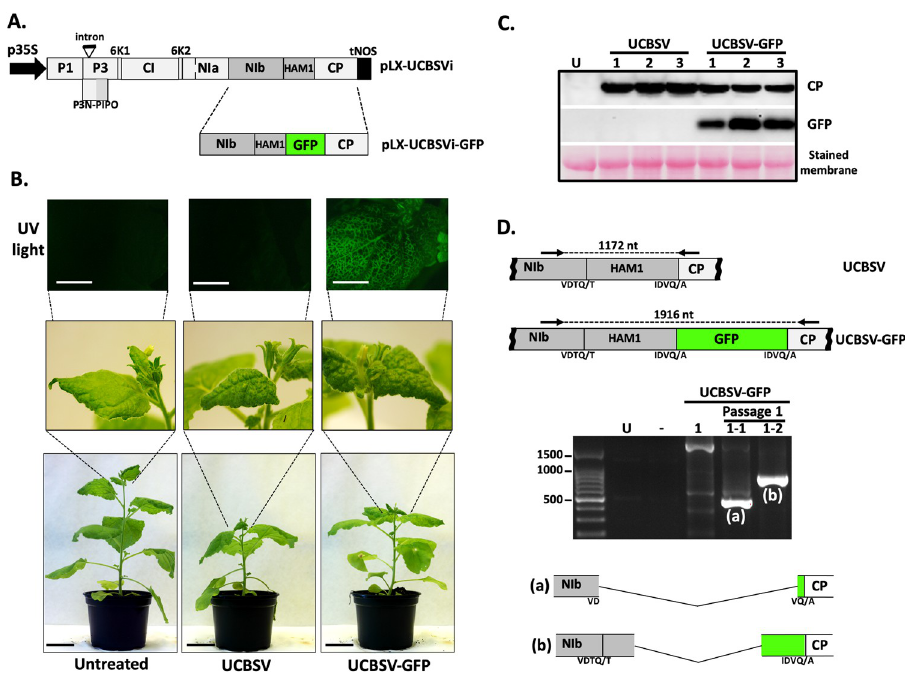
Fig 1. GFP-tagged UCBSV loses HAM1 and GFP coding sequences after one passage in N . benthamiana . (A) Schematic representation of viral constructs based on the pLX-UCBSV [25] used in this experiment. Boxes represent mature viral factors as they are encoded in the viral genome. The presence of an intron in the P3 coding sequence is also indicated. p35S: 35S promoter from cauliflower mosaic virus; tNOS: terminator from the NOS gene of Agrobacterium tumefaciens . (B) Representative pictures taken at 15 days post-inoculation of infected and non-treated N . benthamiana plants under UV radiation and visible light (white bar = 1 cm; black bar = 4 cm). (C) Detection of GFP and UCBSV CP by immunoblot analysis in protein samples from upper non-inoculated leaves of N . benthamiana plants infected with the indicated viruses. Blot stained with Ponceau red showing the large subunit of the ribulose- 1,5-bisphosphate carboxylase-oxygenase is included as a loading control (D) Agarose gel electrophoresis analysis of a viral genomic fragment amplified by RT-PCR from plants infected with UCBSV-GFP after one passage. The upper part shows a schematic representation of the amplified fragment. Black arrows represent primers used for amplification. Sizes of expected PCR products are indicated. Amino acids around the NIaPro cleavage sites are depicted at the bottom.